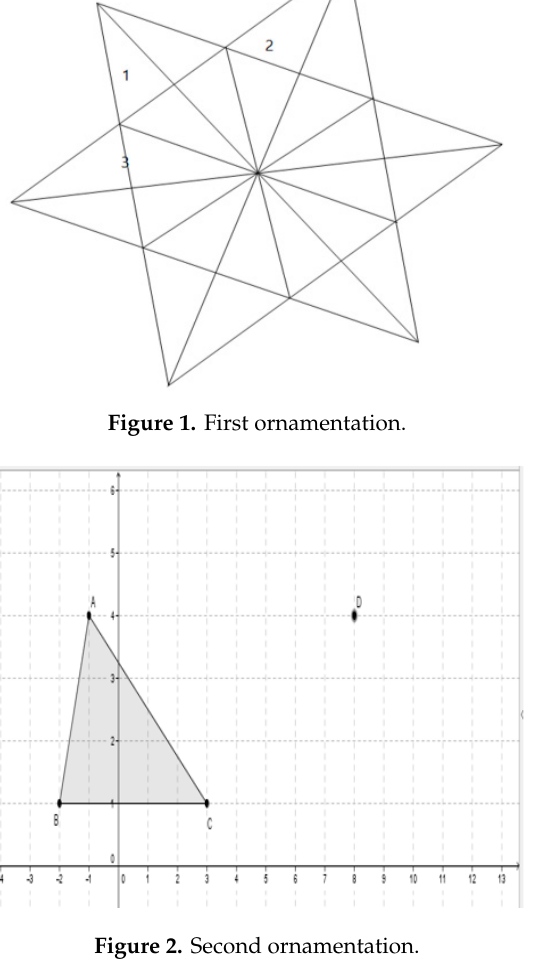
Table 1. Students’ definitions of the congruent triangles, before and after the learning process.